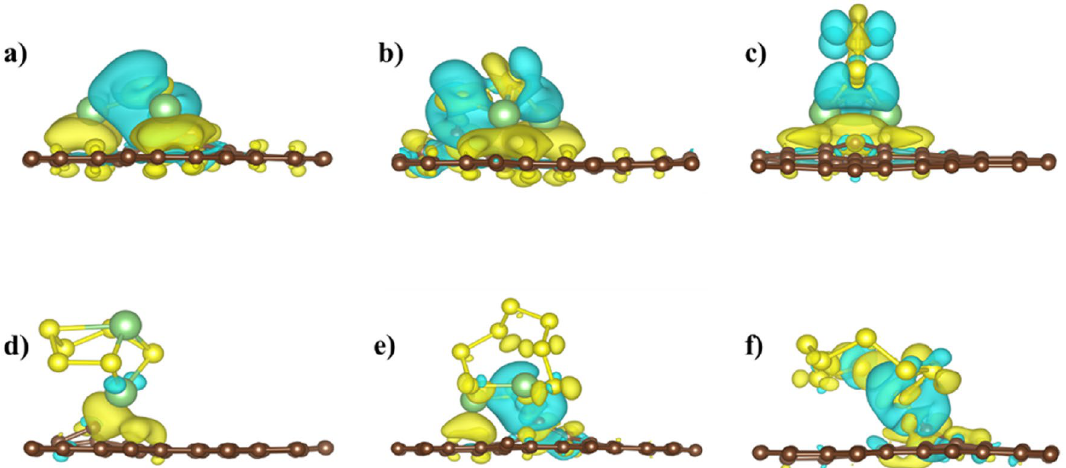
Figure 5. Calculated charge density difference of defective BPN sheet (D1 site) adsorbed with ( a ) Li 2 S, ( b ) Li 2 S 2 , ( c ) Li 2 S 4 , ( d ) Li 2 S 6 , ( e ) Li 2 S 8 , and ( f ) S 8 . Yellow and blue regions indicate charge accumulation and charge depletion, respectively, the iso-surface is set to 0.002 e/A 3 . The brown, green, and yellow spheres correspond to C, Li, and S atoms, respectively.